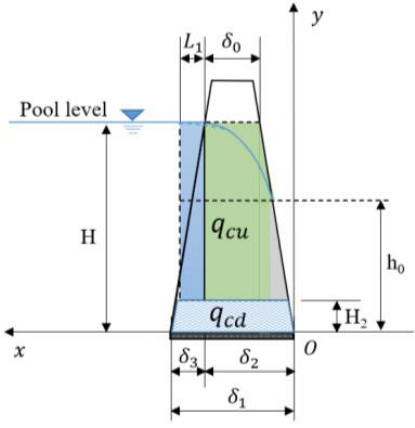
Figure 13. Calculation of seepage flux through the core.